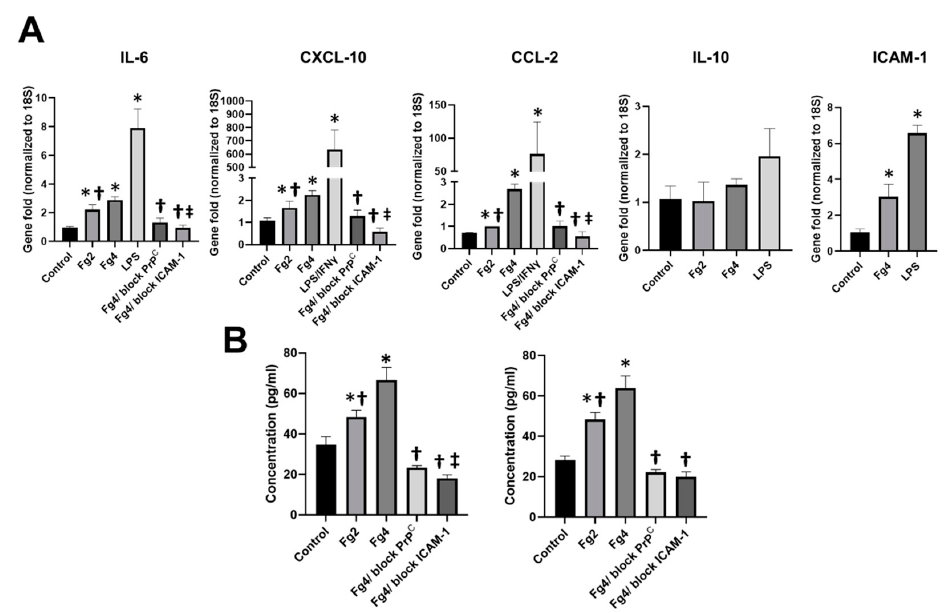
Figure 2. Fibrinogen (Fg)-induced expression of pro-inflammatory cytokines in astrocytes. ( A ) Gene expression of astrocyte pro-inflammatory cytokines interleukin 6 (IL-6), C-X-C motif chemokine 10 (CXCL10), C-C motif chemokine 2 (CCL2), intercellular adhesion molecule-1 (ICAM-1) and anti- inflammatory cytokine interleukin 10 (IL-10) in response to treatment overnight (17 hr) were detected with quantitative real-time polymerase chain reaction (qRT-PCR) analysis. Cells were treated with medium alone (control), 2 mg/mL or 4 mg/mL of Fg (Fg4), 4 mg/mL of Fg in the presence of PrP C function-blocking peptide (Fg4/block PrP C ) and 4 mg/mL of Fg in the presence of function-blocking antibody against ICAM-1 (Fg4/block ICAM-1). Lipopolysaccharide (LPS, 1 µ g/mL), with or without co-stimulation with 20 ng/mL of a murine interferon gamma (IFN γ ), was used as a positive control. Data were presented as a gene fold normalized to 18S, a housekeeping gene. ( B ) Content of the astrocytic IL-6 and CXCL-10 proteins in astrocyte conditioned media was measured by enzyme- linked immunosorbent assay. Cells were treated with medium alone (control), 2 mg/mL or 4 mg/mL of Fg, 4 mg/mL of Fg in the presence of a PrP C function-blocking peptide (Fg4/block PrP C ), and 4 mg/mL of Fg in the presence of a function-blocking antibody against ICAM-1 (Fg4/block ICAM-1). p < 0.05 in all; *—vs. Control, †—vs. Fg4 and ‡—vs. Fg4/block PrP C ; n =